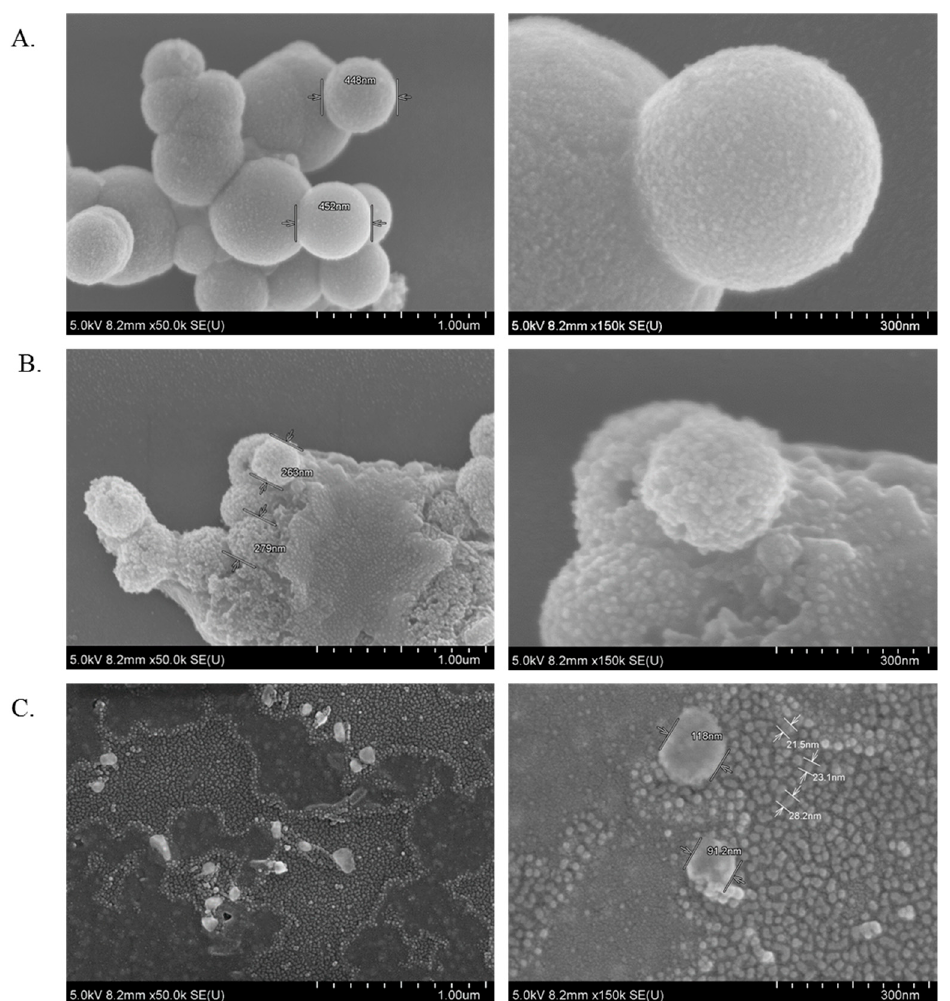
Figure 16. FE-SEM (Field emission scanning electron microscopy) micrographs of NPs. ( A ) micrographs of CA NPs at 1 µm and 300 nm scale; ( B ) micrographs of SMCA NPs at 1 µm and 300 nm scale; ( C ) micrographs CMCA of NPsat 1 µm and 300 nm scale.